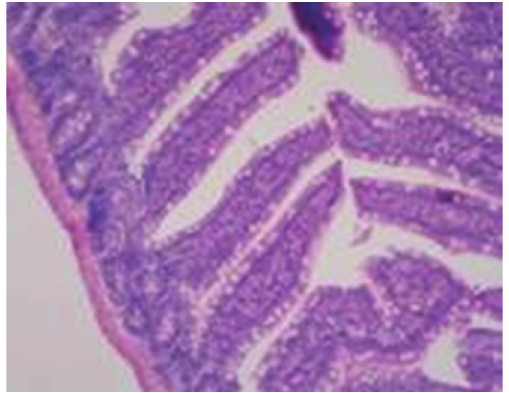
Figure 1: Sham-operated group-28d mucous membrane of small intestine is approximately normal HE × 100.